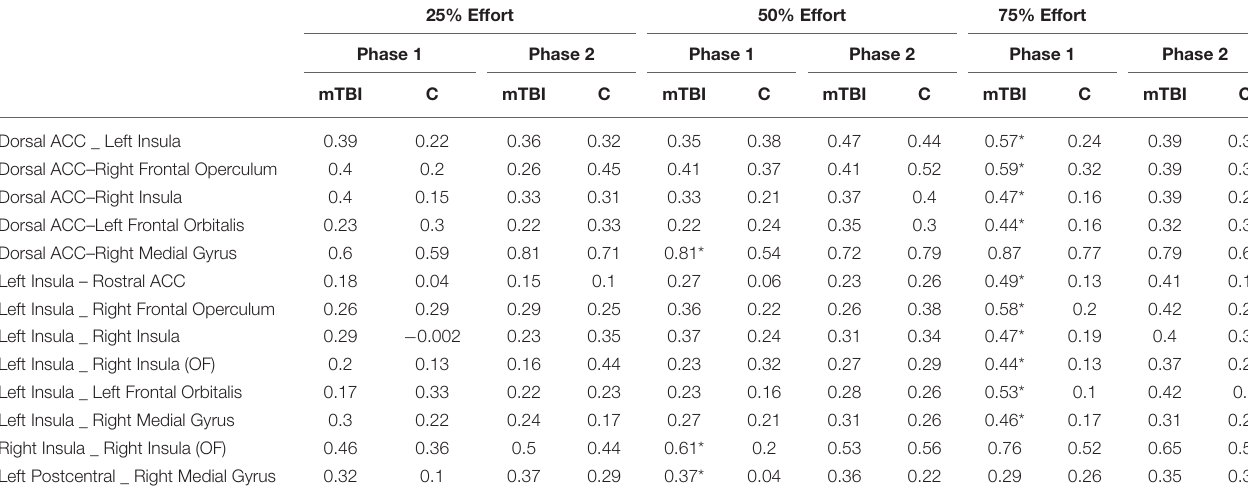
TABLE 3 | Functional connectivity values between the ROIs at each effort level by group.